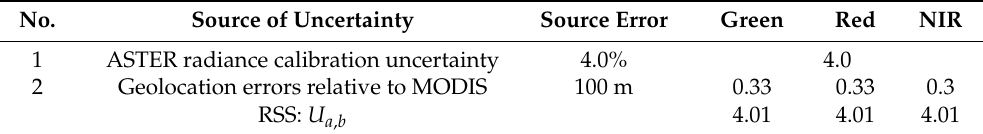
Table 5. Error budget table for spatially aggregated ASTER radiances for ASTER-MODIS cross-calibration VNIR bands showing individual uncertainty factor and combined uncertainty. The three right-most columns list the uncertainty in spatially aggregated ASTER